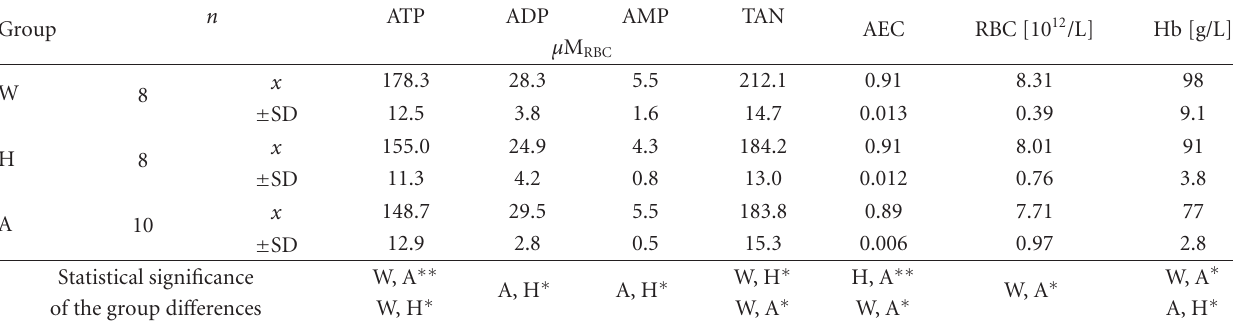
Table 1: Concentration of adenine nucleotides: ATP, ADP, AMP ( µ M), total adenylate nucleotide pool (TAN) and values of the adenylate energy charge (AEC) in erythrocytes of stallions Wielkopolska breed (W), Hanoverian breed (H), Ardenian breed (A) Legend: x -mean;